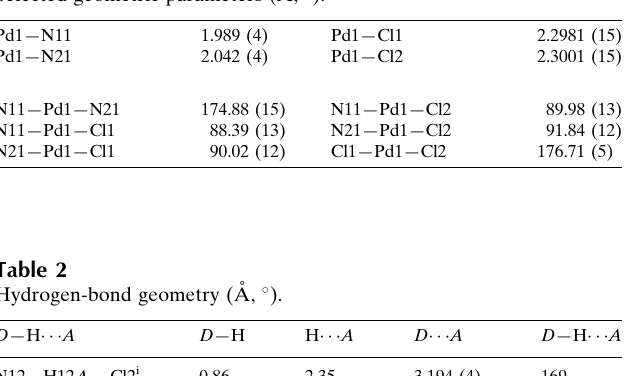
Selected geometric parameters (A˚ , (cid:4) ).